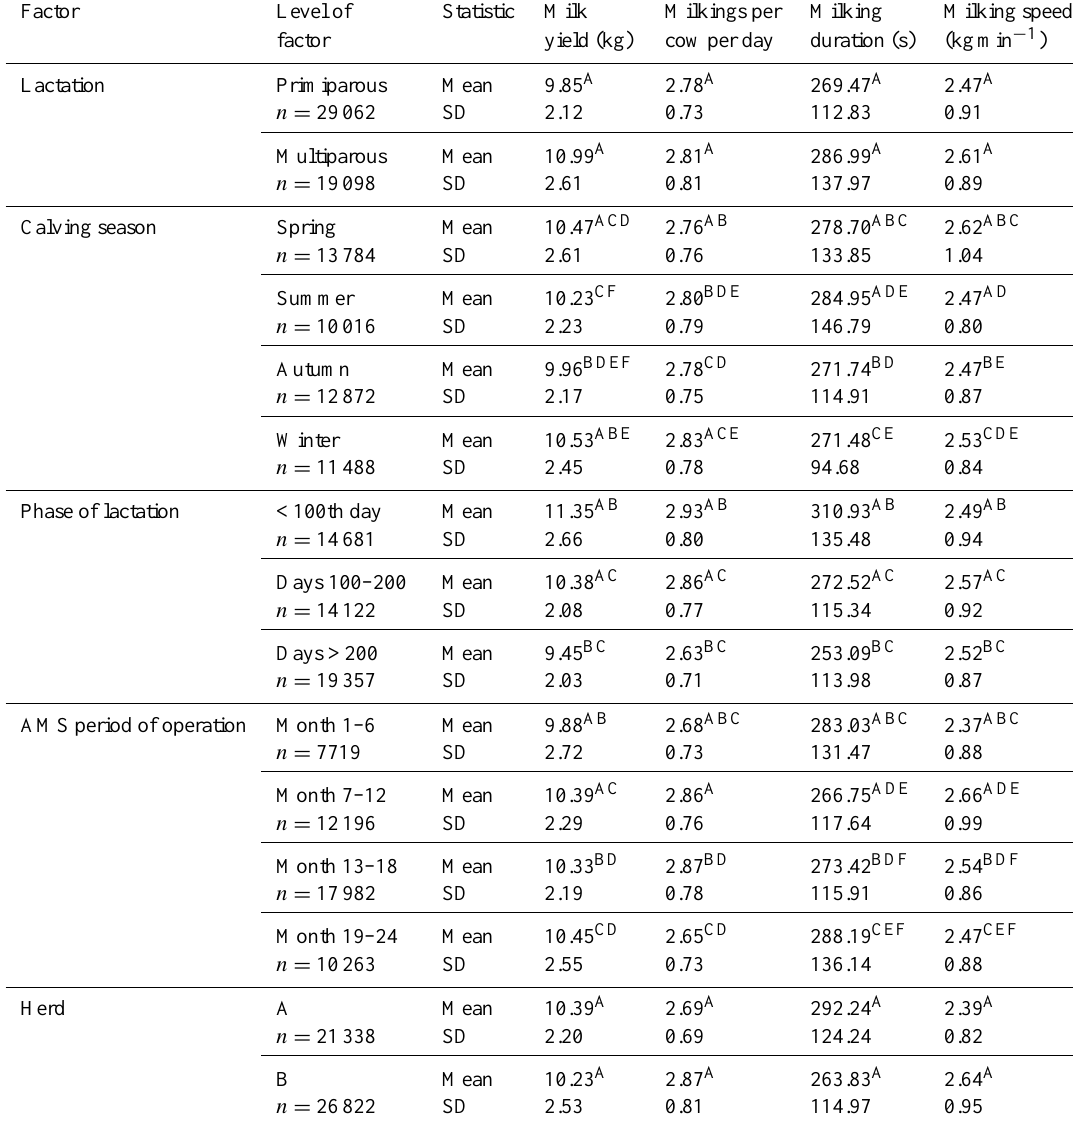
Table 2. Level of milking parameters depending on factors studied. Factor Level of Statistic Milk Milkings per Lactation